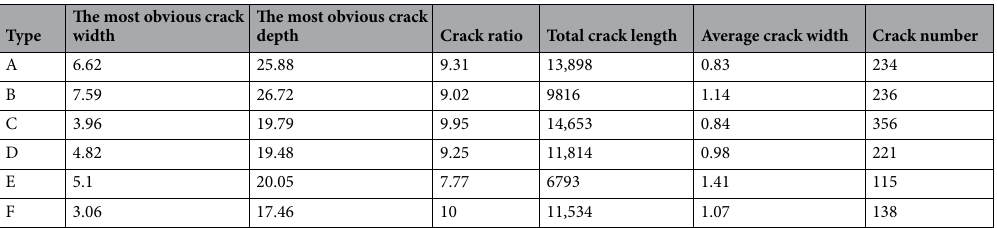
Table 4. Original data.